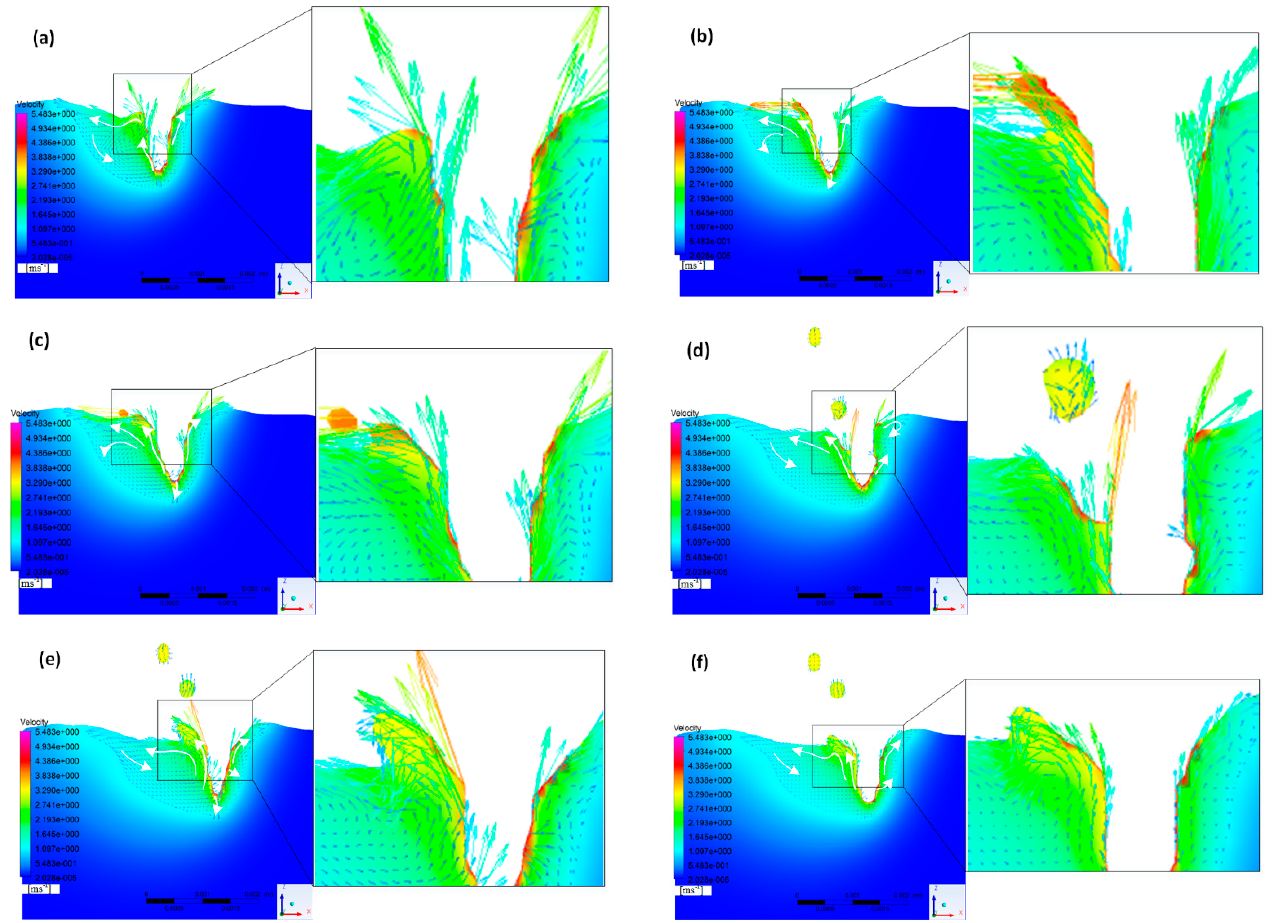
Figure 8. Flow field of molten pool when the welding speed was 9 m/min: ( a ) t = 7.6 ms, ( b ) t = 7.9 ms, ( c ) t = 8 ms, ( d ) t = 12.5 ms, ( e ) t = 13.2 ms, ( f ) t = 13.4 ms.